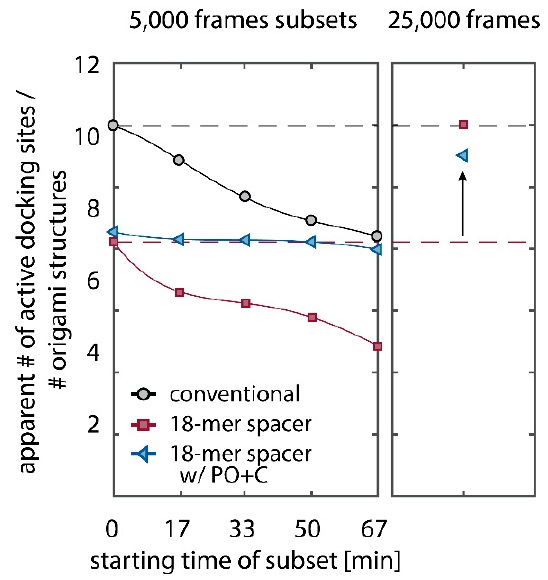
Figure A5. The observed lower number of active docking sites for the 18-mer spacer (conditions 3a and 3b) is caused by the lower association rate of the extended imager. Identifying active docking sites on the whole time series of 25,000 frames, recovers the number of initially active docking sites expected from the conventional imaging condition (condition 1).